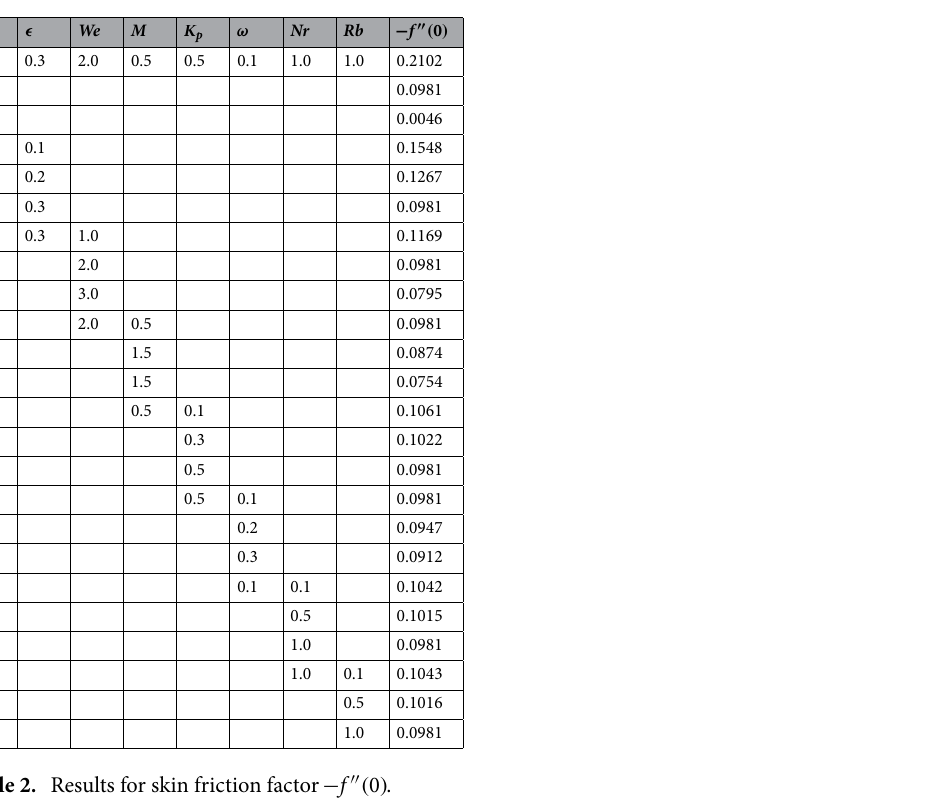
Table 2. Results for skin friction factor